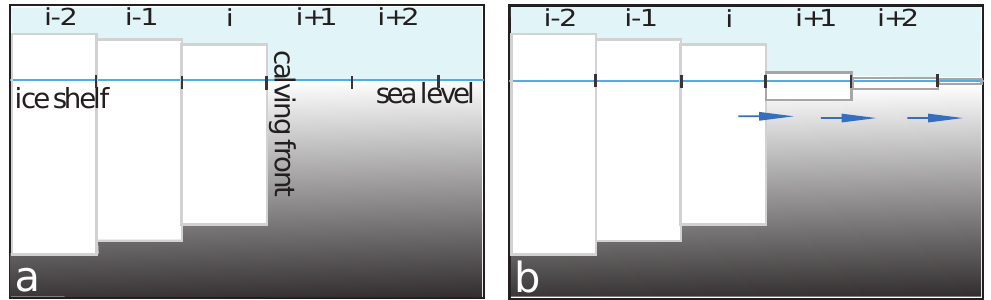
Fig. 1. (a) Schematic of a discretized ice shelf is shown in lateral view with decreasing ice thickness in positive i-direction. The local calving front is located at the interface between the last shelf grid cell [ i ] and the adjacent open ocean cell [ i + 1 ] . (b) In every time step a volume increment is calculated for each grid cell according to the scheme approximating Eq. (1). Thus, in every time step, the marginal cliff moves one grid cell further into the open ocean and may thin out relatively fast.